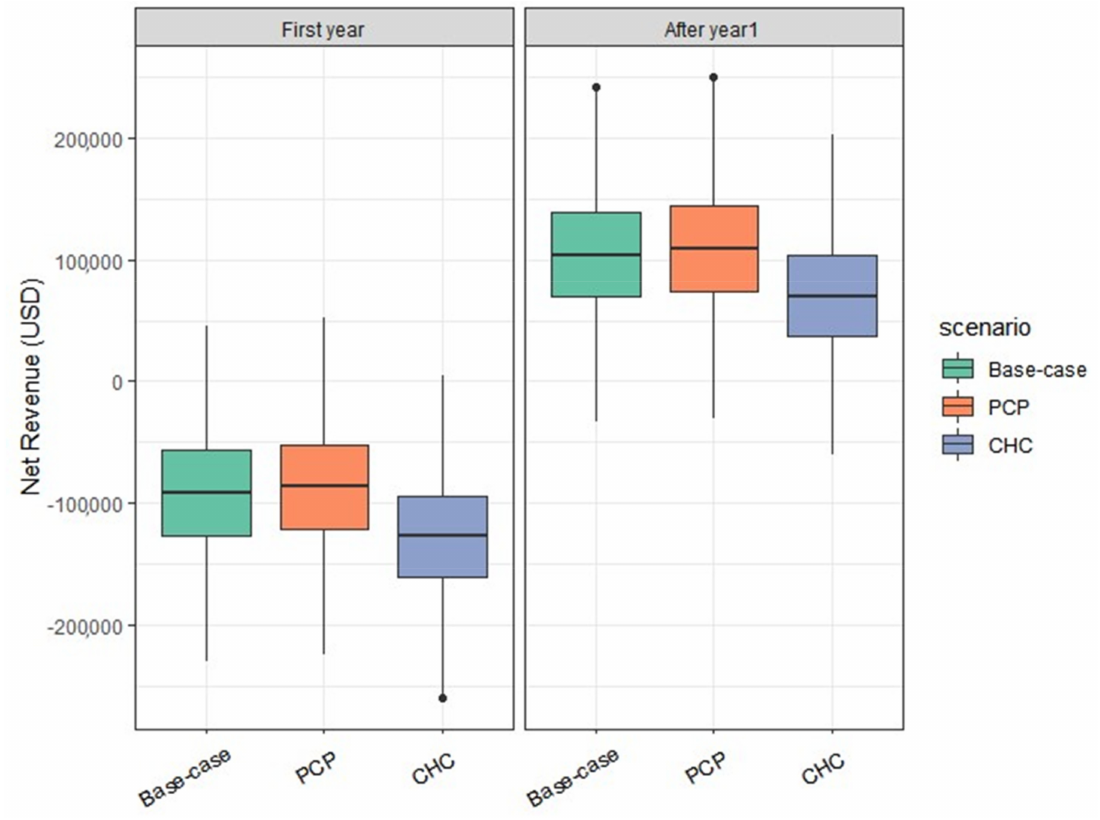
Figure 3. Impact of di ff erent payer distributions, showing the minimum (lower whisker), maximum(upperwhisker), median(centerofthebox), lowerquartile(bottomofbox), andupperquartile (top of box) values. Base case = national average; PCP = primary care practice; CHC = community health